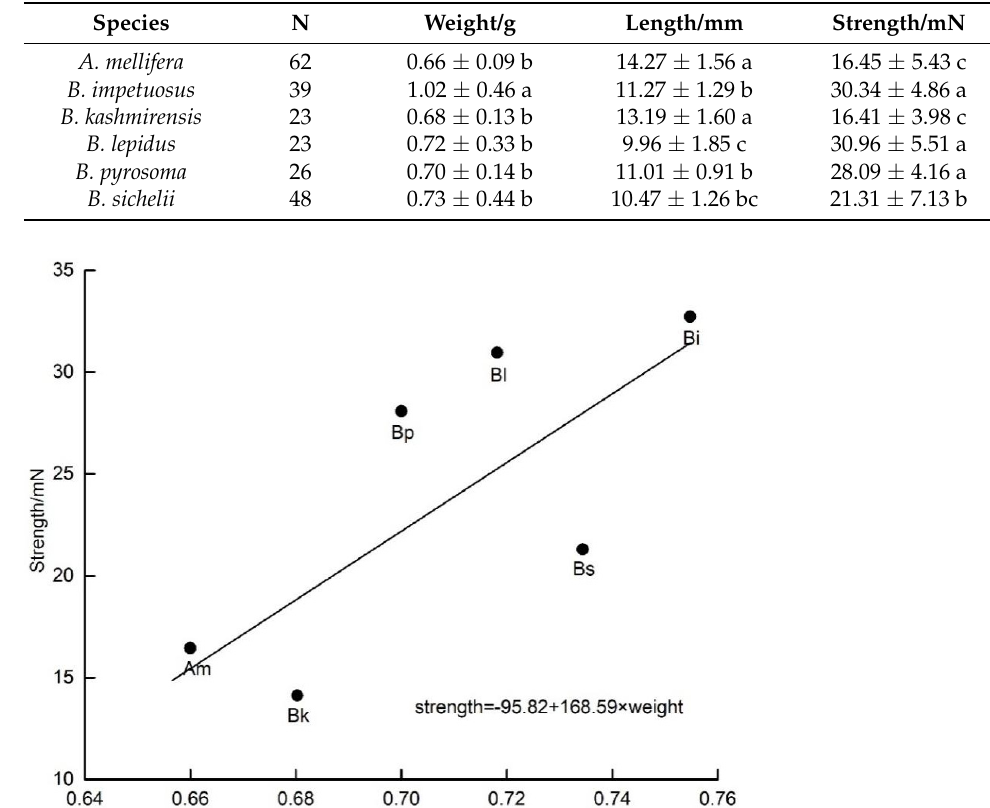
Table 2. The weight, length, and strength of visitors. B. impetuosus , B. lepidus , and B. pyrosoma are visitors of D. caeruleum . Means ± SD are shown. Different letters (a, b, and c) within the same column indicate significant difference at p < 0.05.